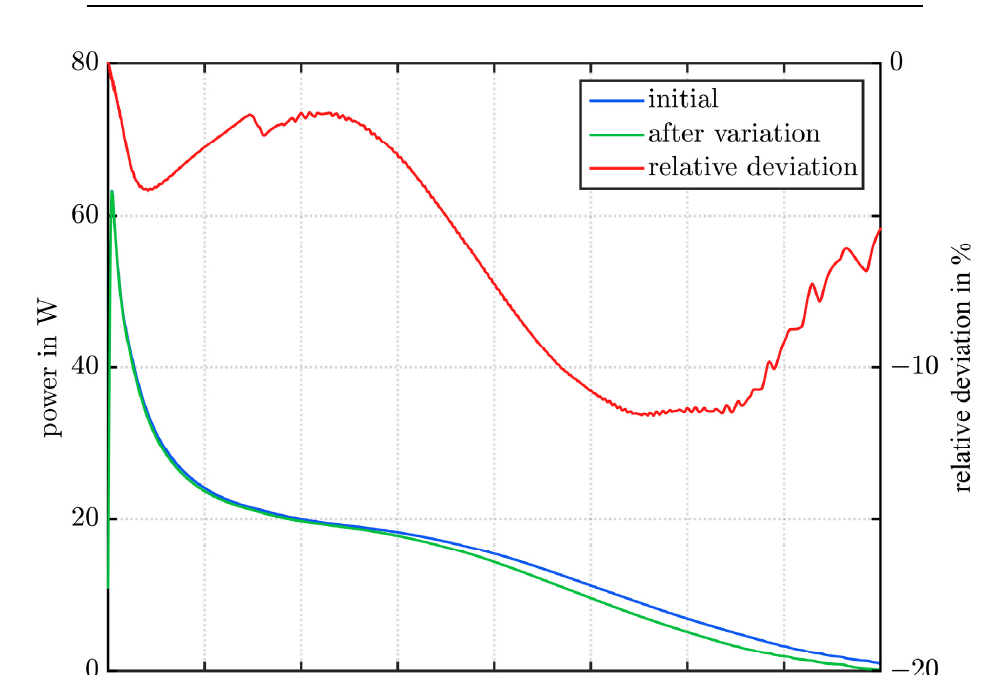
Figure A1. Power over time curve for charging of the standard case and the case with a decreased melting enthalpy as well as the regarding relative deviation.